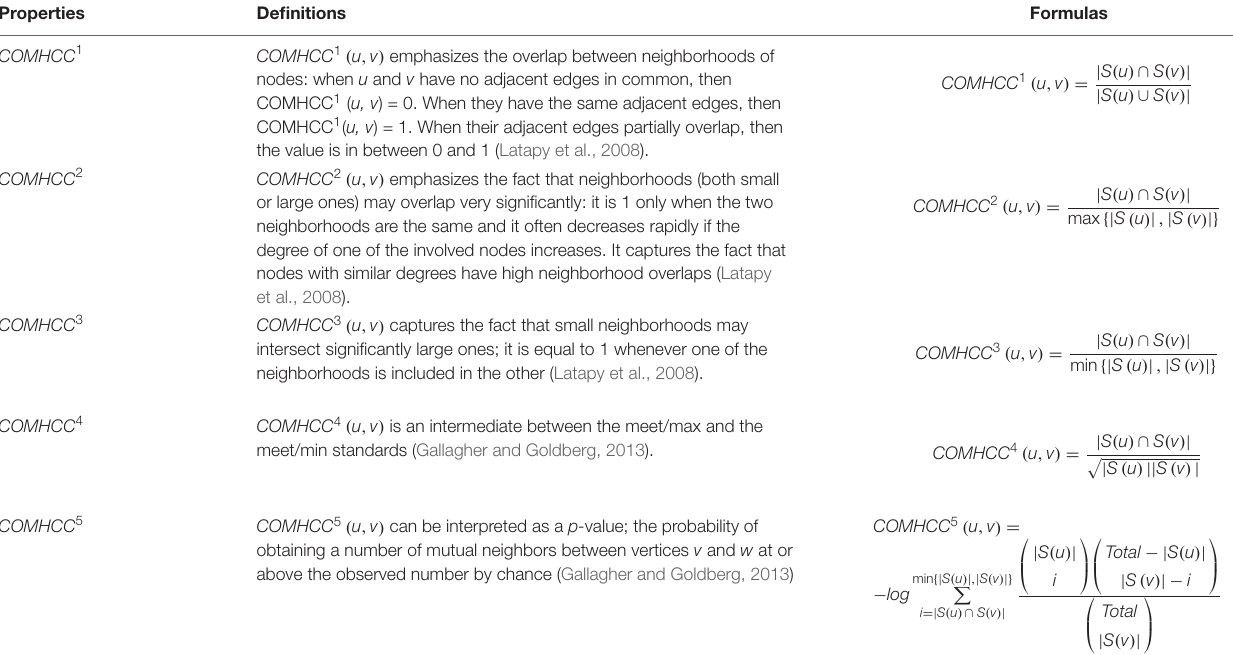
TABLE 2 | Definitions and calculation formulae of clustering coefficients defined on a pair of